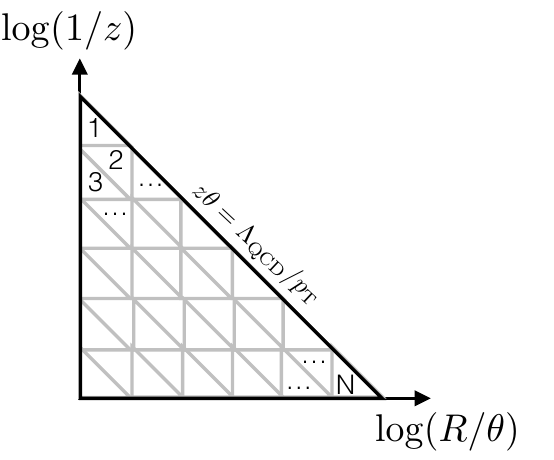
Figure 1 . A tiled version of the Lund plane where each of the N triangles has the same area. The non-perturbative regime is defined by zθ > Λ QCD /p T